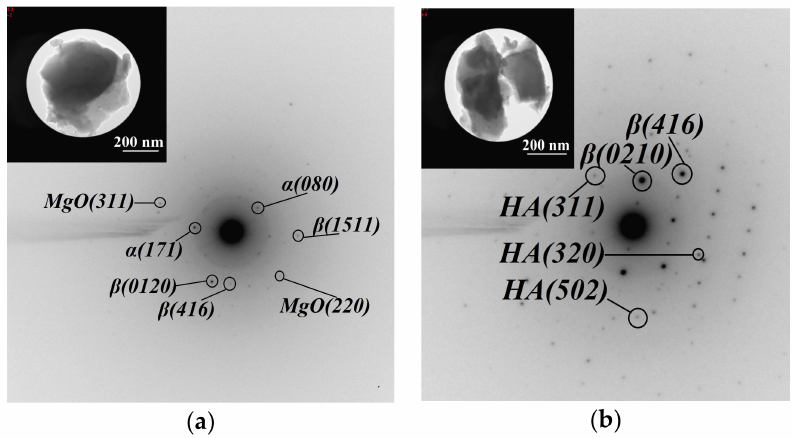
Figure 9. Transmission electron microscopy (TEM) bright field (BF) images and selected area diffraction (SAD) patterns of the fragments of the CaP coatings deposited for 5 min under different MAO voltages (V): ( a ) − 400; ( b ) − 500; α -TCP– α ; β -TCP– β .